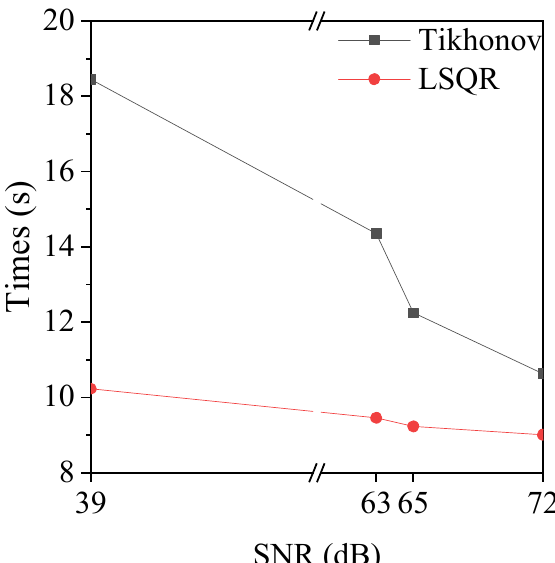
Figure 11. The time taken by the two algorithms for different intensity noises.